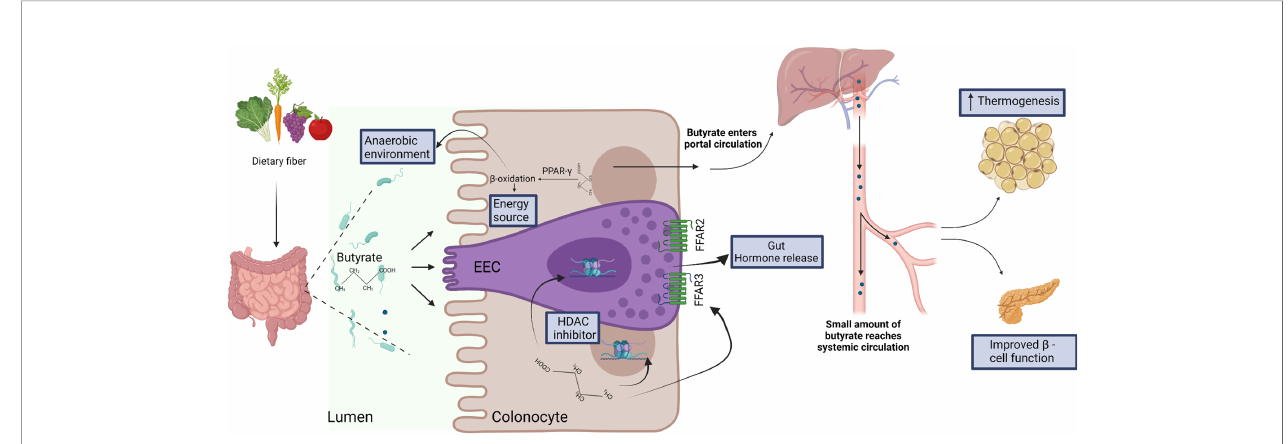
FIGURE 2 | Dietary fi ber is fermented by the gut microbiota to produce short chain fatty acids, including butyrate. Butyrate is ef fi ciently absorbed by colonocytes and is utilized as energy source. Butyrate-mediated activation of the peroxisome proliferator-activated receptor-gamma (PPAR- g ) induces b -oxidation and consumption of oxygen, thus facilitating the establishment of anaerobic conditions that are required for the growth and function of several anaerobic gut commensals (57). In the specialized enteroendocrine cell (EEC), butyrate binds free fatty acid receptors (FFAR) FFAR2 and FFAR3 and regulates gut hormone release (73). Butyrate also acts as histone deacetylase (HDAC) inhibitor to regulate gene expression in EEC (76) and enterocytes (63). After absorption and utilization by colonocytes, the residual butyrate is fi rst drained into the portal circulation, and then into the peripheral systemic circulation (29). In the systemic circulation, butyrate may regulate thermogenesis in brown adipose tissue (66) and b -cell function in pancreas